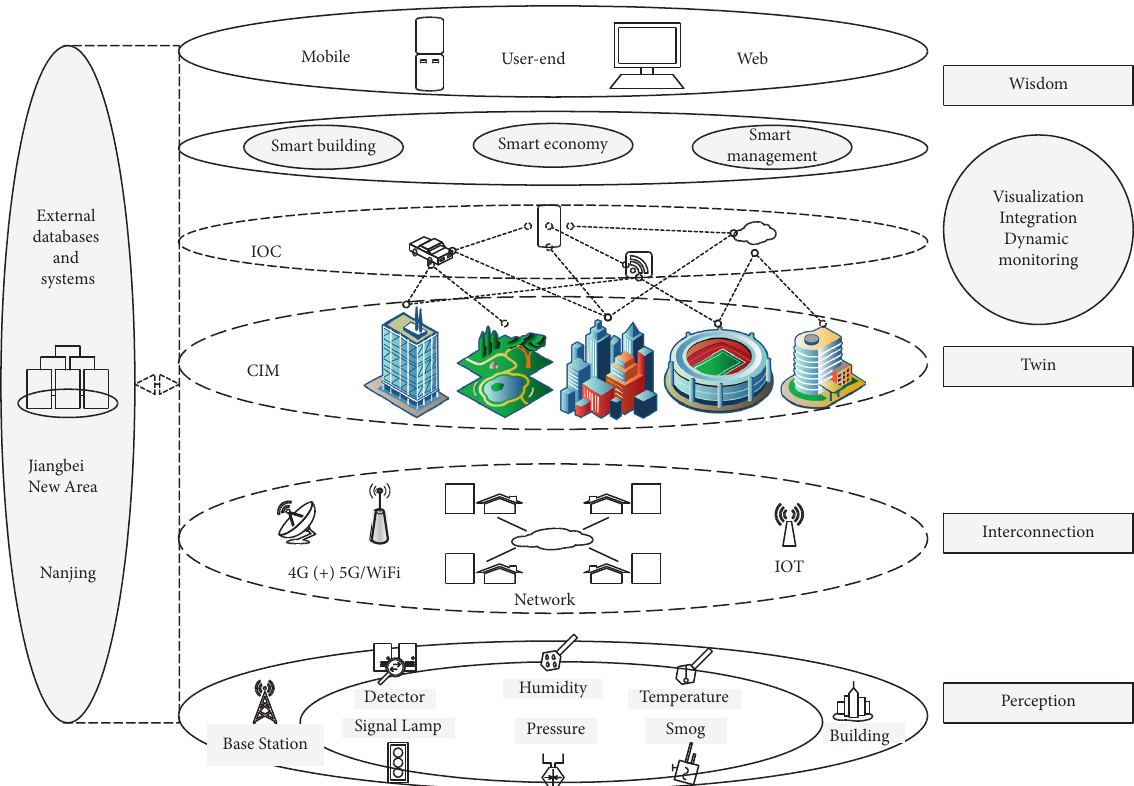
Figure 3: The overall structure of the CBD in the Jiangbei New